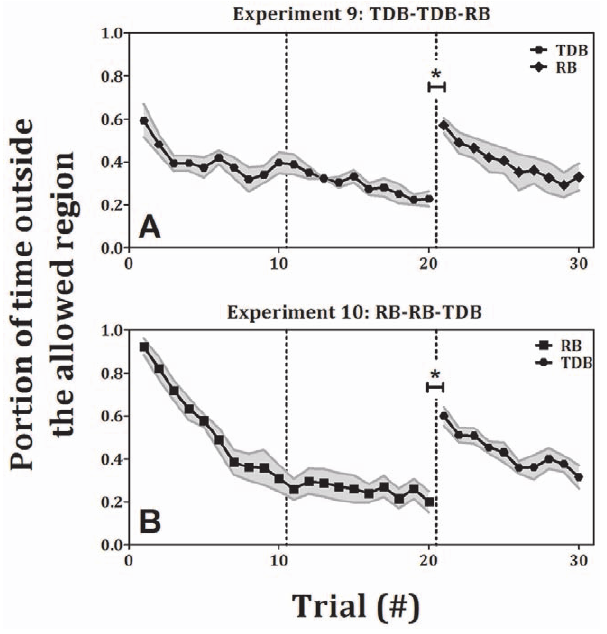
Figure 8. Error as a function of trial number for experiments 9 and 10. ( 6 standard error). Each shape represents a different condition of the task: hexagons – truly discrete big, diamonds – rhythmic big. In the transition from truly discrete movements to rhythmic ones (A) and from rhythmic movements to discrete ones (B), there is a significant increase in